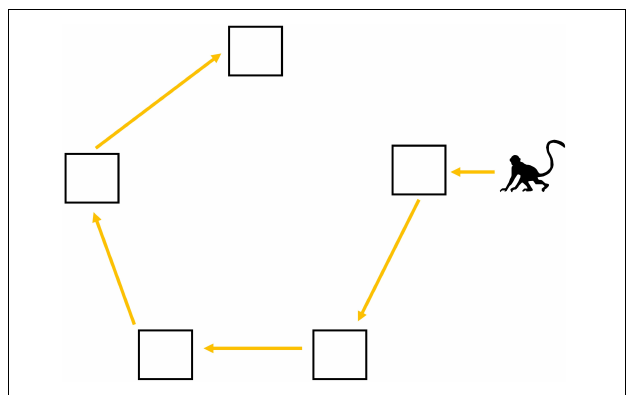
FIGURE 1 | Travel path that minimizes travel distance if visiting all food patches in a pentagon-shaped foraging